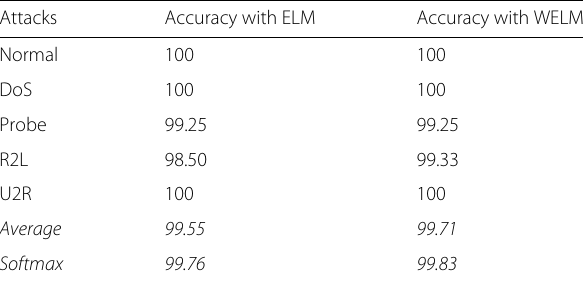
Table 6 Proposed system based on WELM performance on